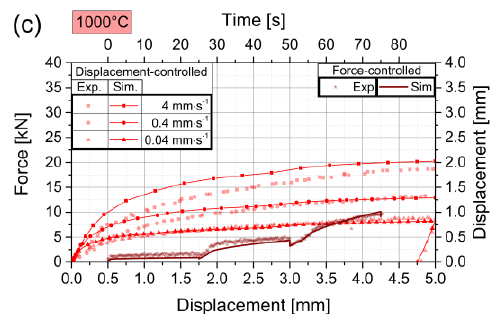
Figure 7. Simulated material response for displacement- and force-controlled conditions in comparison with experimental data. Displacement-controlled curves correspond to the left and lower axes, whereas force-controlled curves correspond to the right and upper axes. The three graphs show the three representative temperatures ( a ) 800 °C, ( b ) 900 °C, and ( c ) 1000 °C.